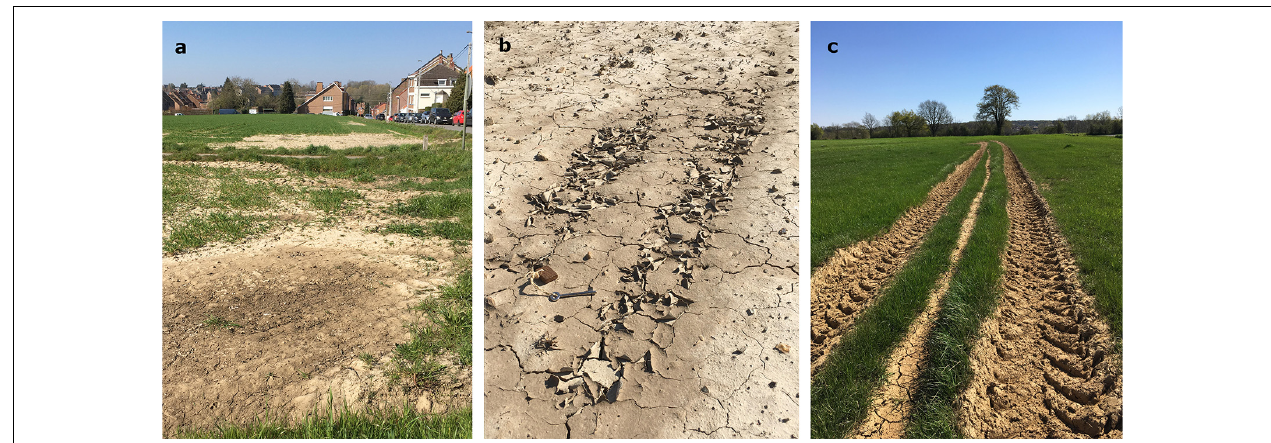
FIGURE 2 | Example of soil degradation brought about by compaction. (a) Field in Braine-l’Alleud (Belgium) where the use of heavy machinery, including sugar beet harvesters, over the years has resulted in soil compaction, lack of drainage, and difficulty for crops to germinate, (b) in this same field, evidence of dispersion of the soil at the surface, which at this point (April 4, 2020) is as hard as concrete when dry, (c) field soil in Lamairé (Deux-Sèvres, France) where pesticide application using heavy machinery has resulted in intense compaction. At various places, the tractor tracks are 20 cm deep, and the soil is once again extremely hard.